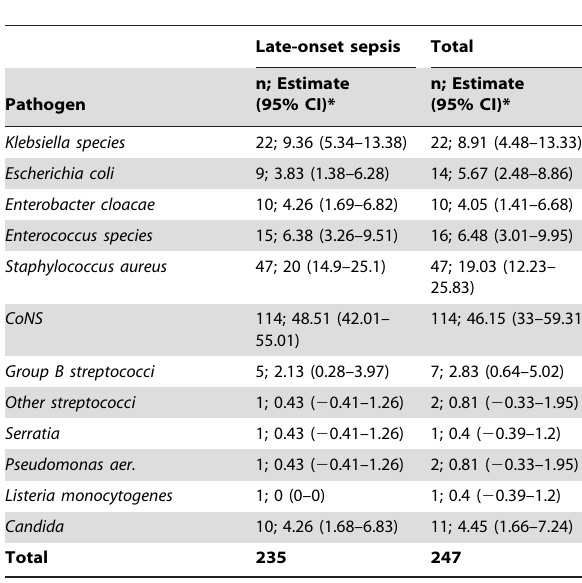
*Estimate: estimated risk for specific pathogen/100 cases of blood-culture proven sepsis.